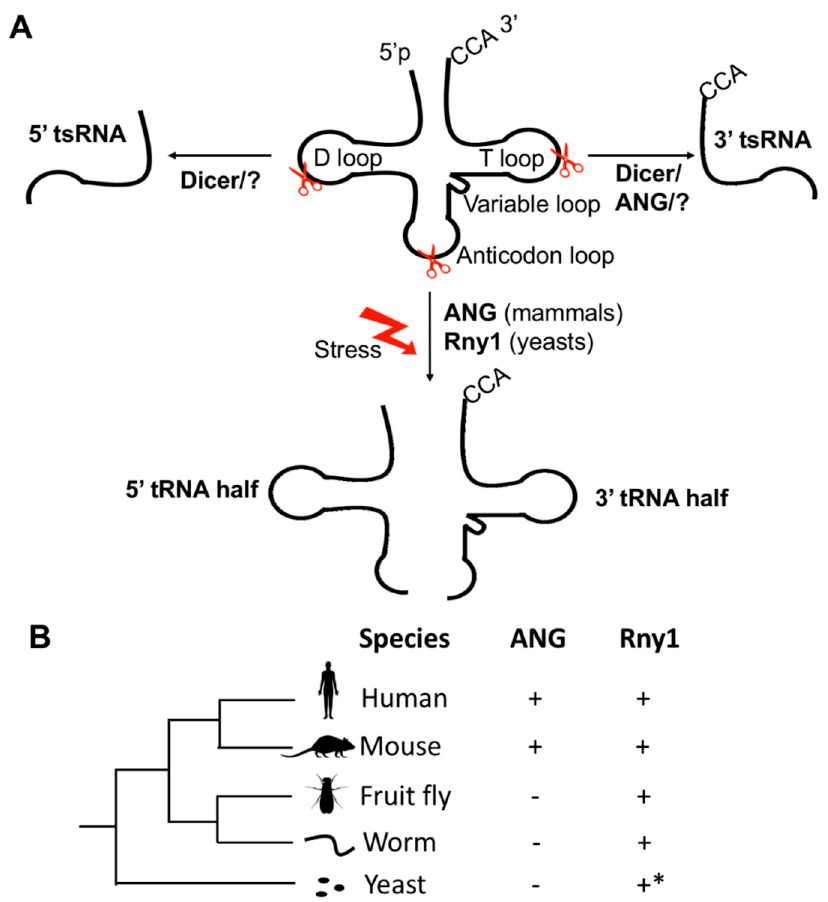
Figure 1. The biogenesis of tRNA-derived small RNAs (tsRNAs) from mature transfer RNAs (tRNAs). ( A ) Processing and classification of tsRNAs derived from mature tRNAs. The cleavage of an RNase at the D-loop or T-loop of a tRNA can generate a 5 ′ or 3 ′ tsRNA, respectively. The 5 ′ tsRNA could be generated by DCR, while 3 ′ tsRNA could be produced by DCR or ANG. Other unknown RNases (?) might also participate in tsRNA generation. The tRNA halves are cleaved by Rny1 and angiogenin (ANG) in yeasts and mammals, respectively. ( B ) The conservation patterns of Rny1 and ANG in eukaryotes. Among the five representative species, ANG is only present in humans and mice. Although the homologous sequence of Rny1 can be found in all the five species, currently Rny1 is only demonstrated to be involved in the biogenesis of tRNA halves in yeasts.